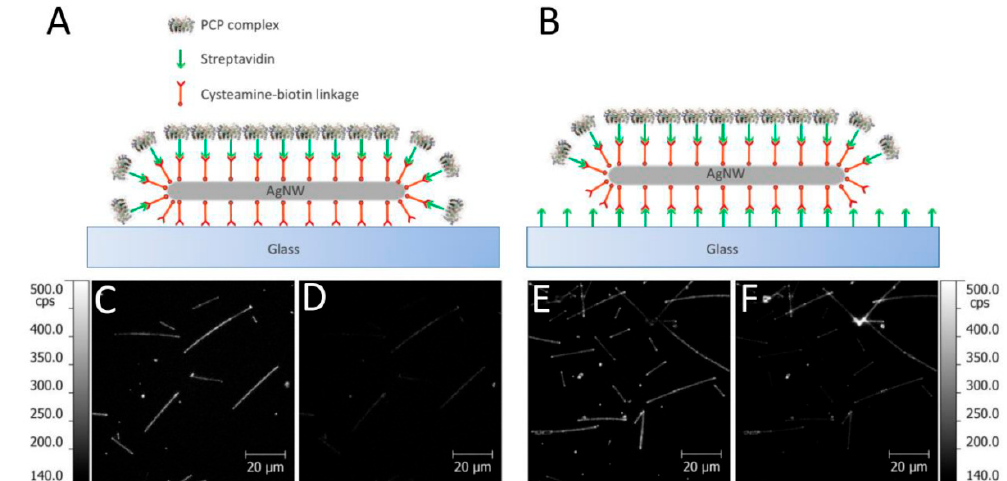
Figure 3. Schematic illustration of the structural differences between the two used substrates: bare glass ( A ) and streptavidin-covered glass ( B ). The fluorescence maps collected at 12.5 s (moment of maximum fluorescence intensity during the experiment) and at 300 s from the start of the measurement (( C , D ), respectively) for bare glass substrate, and analogous fluorescence maps recorded at 30 s and 300 s from the start of the measurement for the streptavidin-covered glass (( E , F ), respectively).